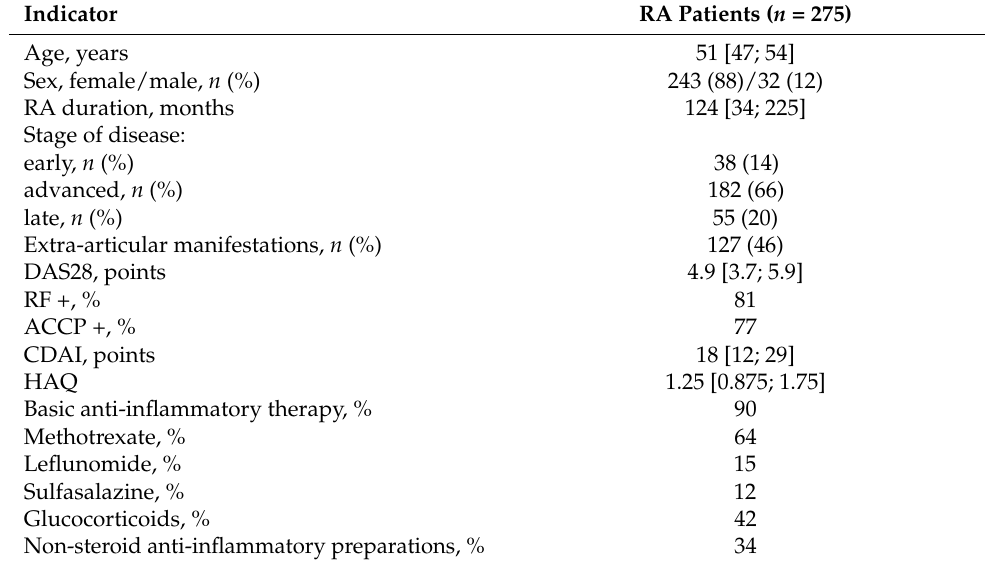
Table 1. Clinical characteristics of study participants with